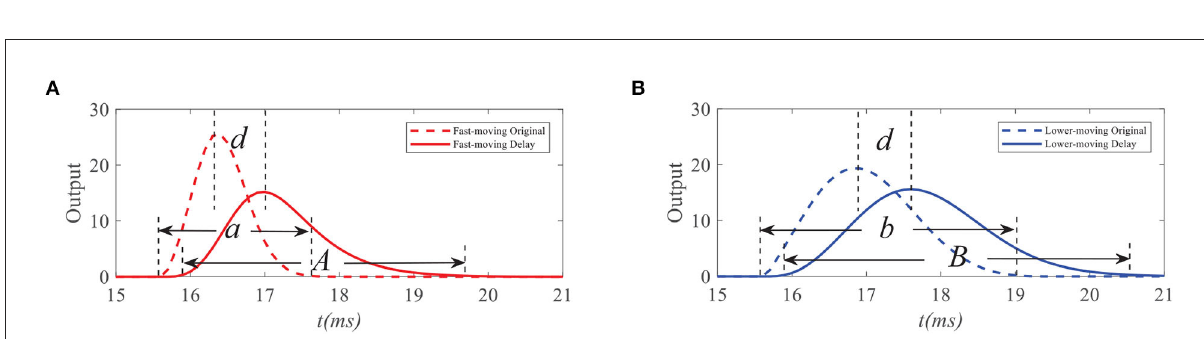
FIGURE4 Original STMD outputs and feedback delay signal to small targets with different velocities. a , A (or b , B ) denote the response durations of STMD output and feedback delay signal to fast-moving (or slow-moving) target, respectively (A,B) . d denotes the time-delay length.